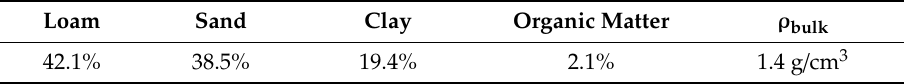
Table 1. Texture of the soil where the Sentek probes were